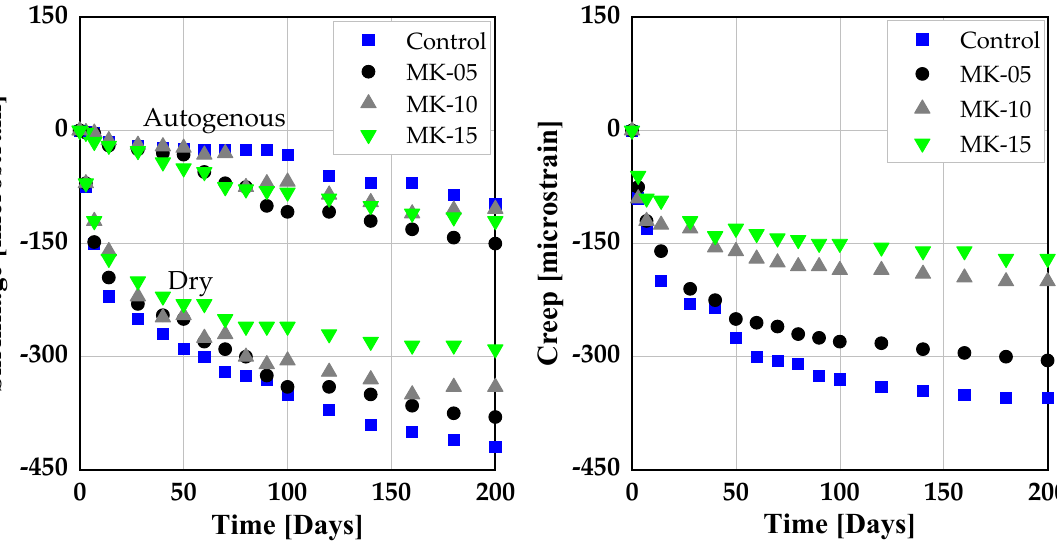
Figure 10. Shrinkage and creep of conventional vibrated concrete (CVC) produced with MK [120].